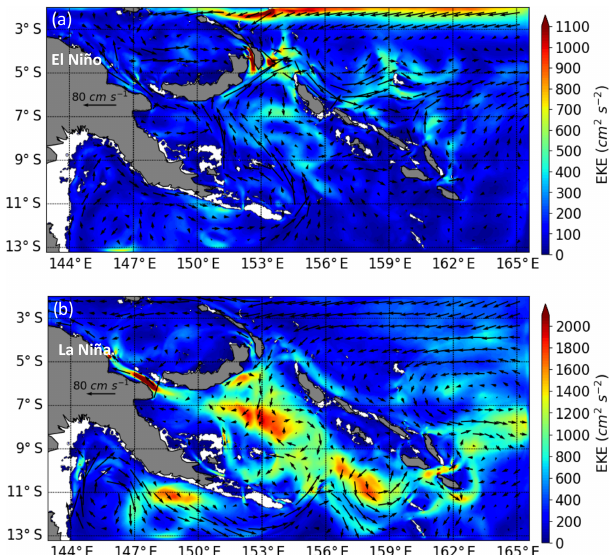
Figure 2. Mean surface EKE (shading; units: square centimeters per second squared) and mean surface circulation (arrows) from the 3-month TIDE simulations during (a) the El Niño state and (b) the La Niña state. Note the change of color bar between the two ENSO states. White color is for bathymetry of less than 50m. Isobathy- metric lines are from the NOAA/ETOPO2v2 bathymetric file from the Smith & Sandwell database (https://doi.org/10.7289/V5J1012Q, National Geophysical Data Center,